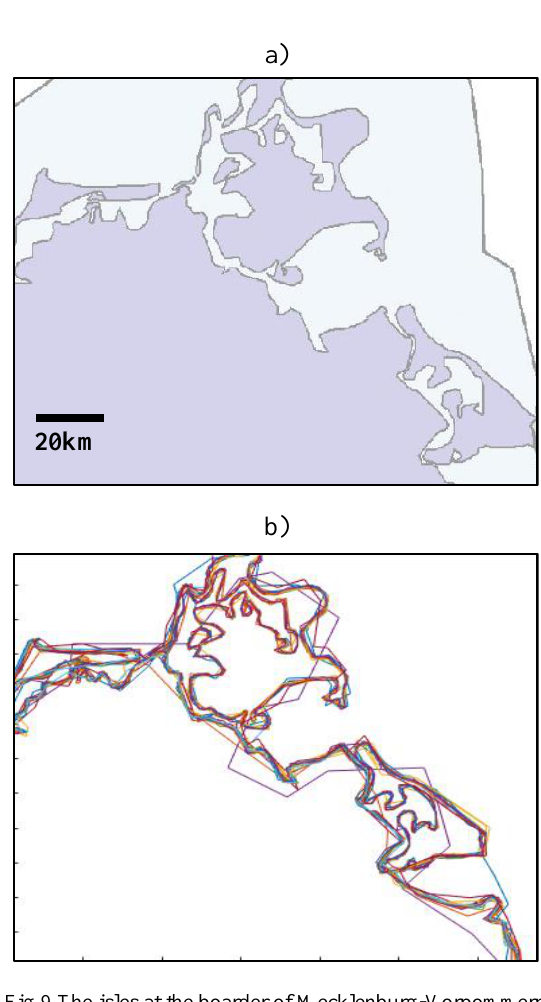
Fig 9 The isles at the boarder of Mecklenburg-Vorpommern were collected by some of the students and by some not: (a) data source; (b) multiple data